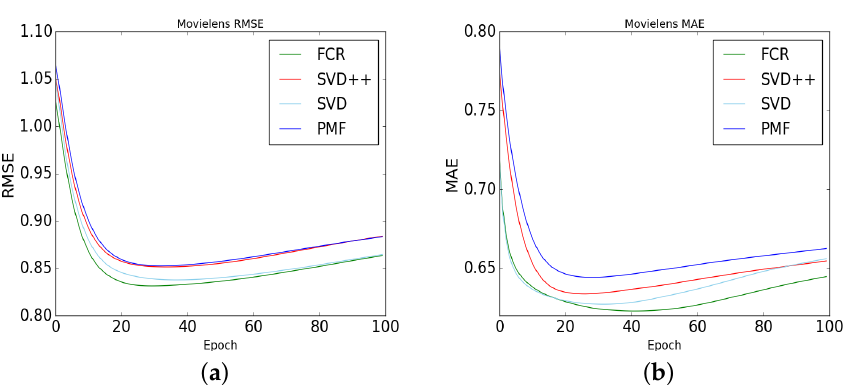
Figure 2. Compared with other baseline models, the FCR model (without social influence diffusion layer), the lower RMSE and MAE, the better the performance. ( a ) Movielens RMSE, ( b ) Movie- lens MAE.